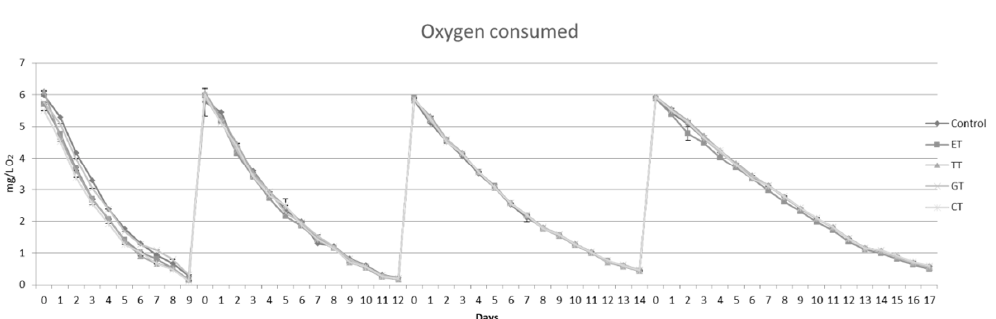
Figure 1. Average oxygen concentrations (mg / L) measured in each wine. All the data are expressed as means ± standard deviation. 251